Question: How would you classify this visualization?
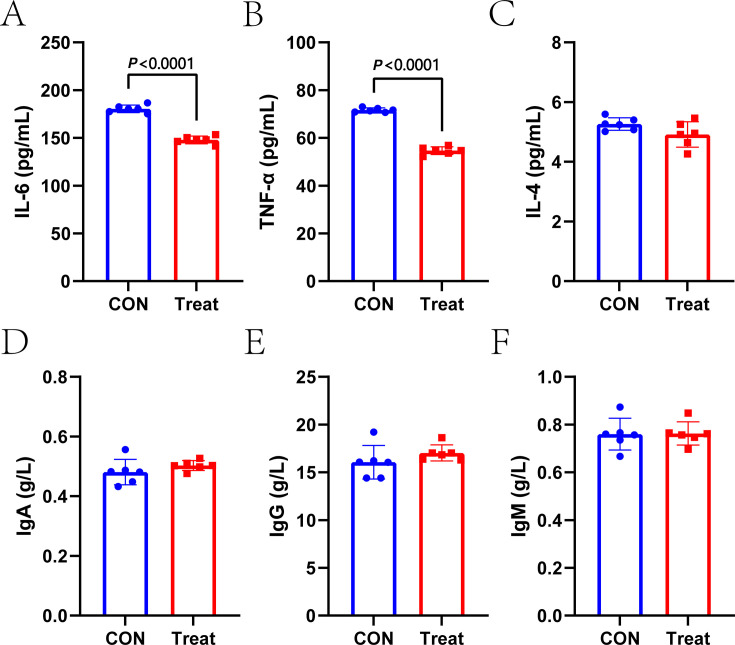
Answer: bar